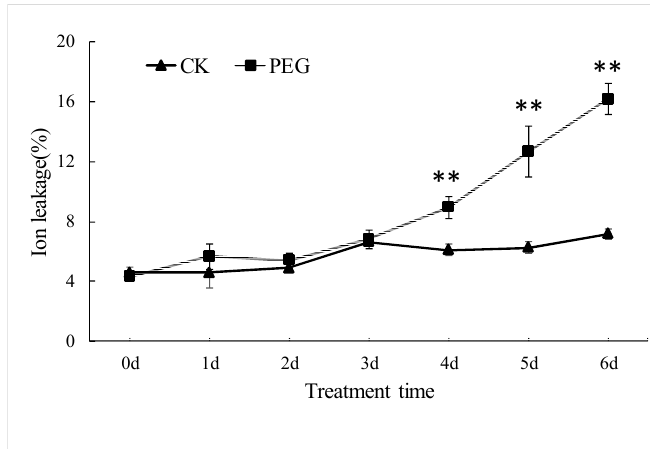
Figure 1. Ion leakage of wheat leaves under drought stress and well-watered condition. ** represents that there is significant differences in wheat in two treatments at p < 0.01. “d” in treatment time represents day here.